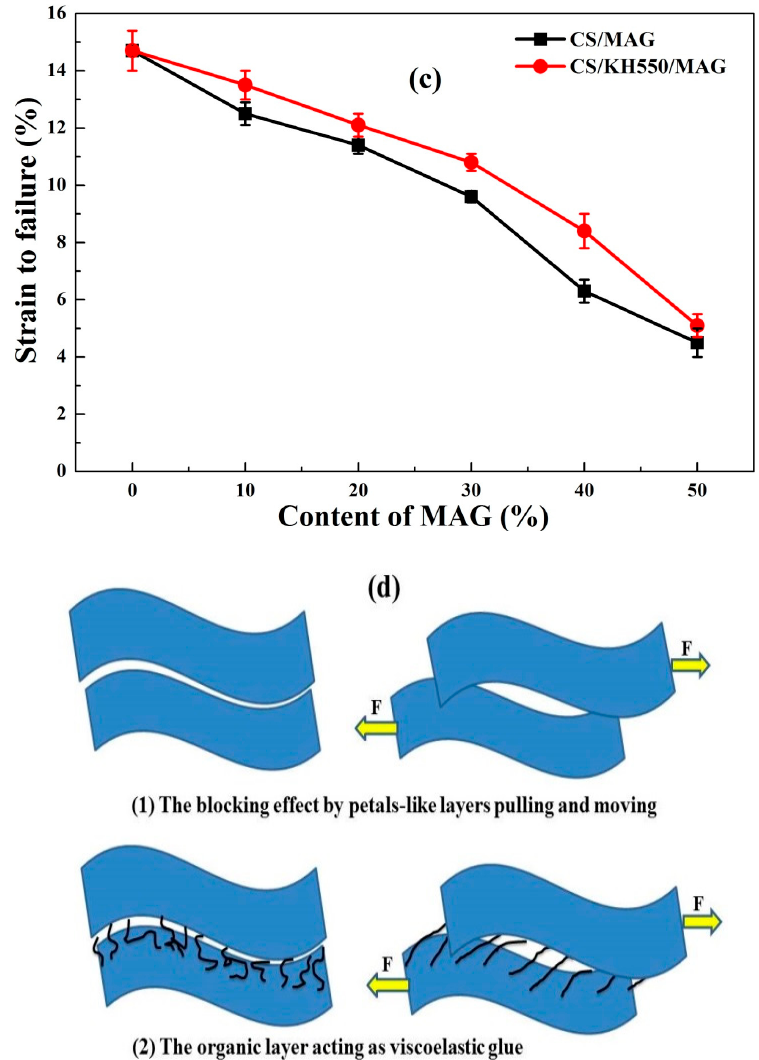
Figure 6. Mechanical properties of ( a ) tensile modulus, ( b ) tensile strength, ( c ) strain to failure, and ( d ) force schematic diagram of MAG layers pulling and moving of the CS/MAG and CS/KH550/MAG hybrid membranes.